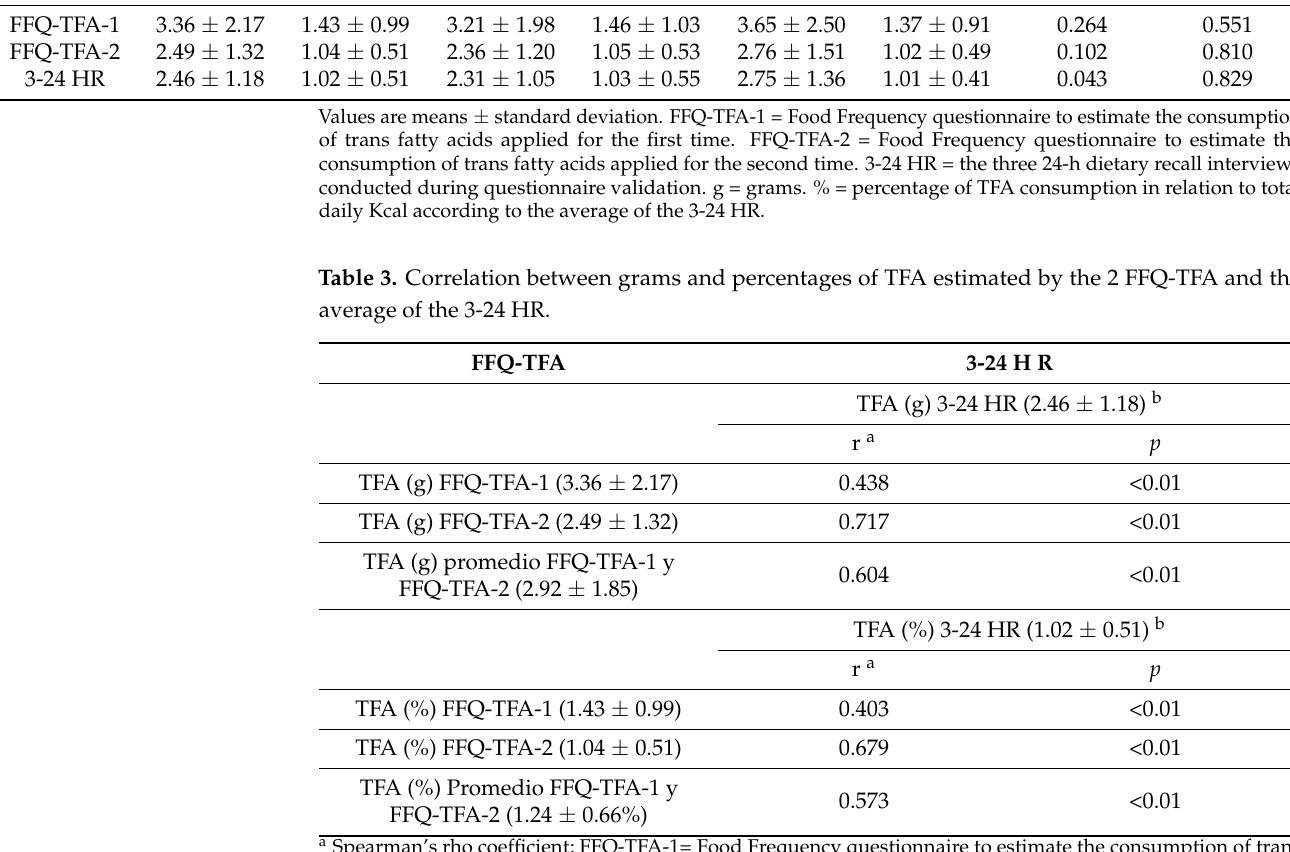
Table 2. Estimated consumption of TFA/day ( n = 162) by FFQ-TFA and 3-24 HR. Total Women Men g % g % g % p (g) p (%)